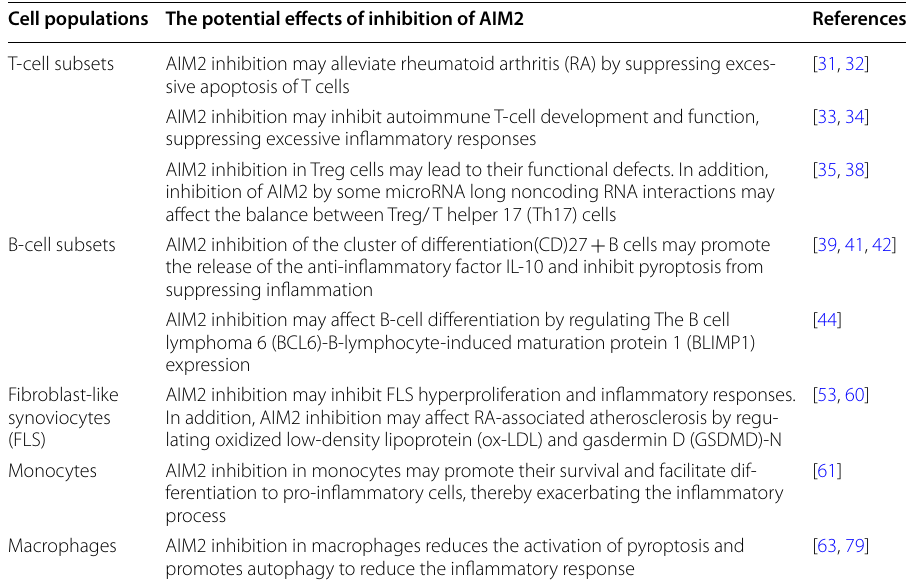
Table 1 Potential effects of absent in melanoma 2 (AIM2) inhibition on RA Cell populations The potential effects of inhibition of AIM2 T-cell subsets